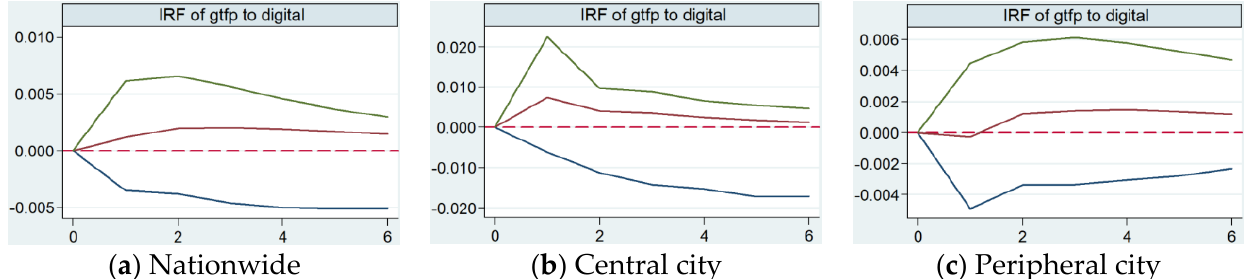
Figure 2. The impulse response diagram of GTFP faced with the shock of digital economy.( The green and blue lines represent the upper and lower boundaries of the 95% confidence interval respectively, and the red lines in the middle are the impulse response trace.)